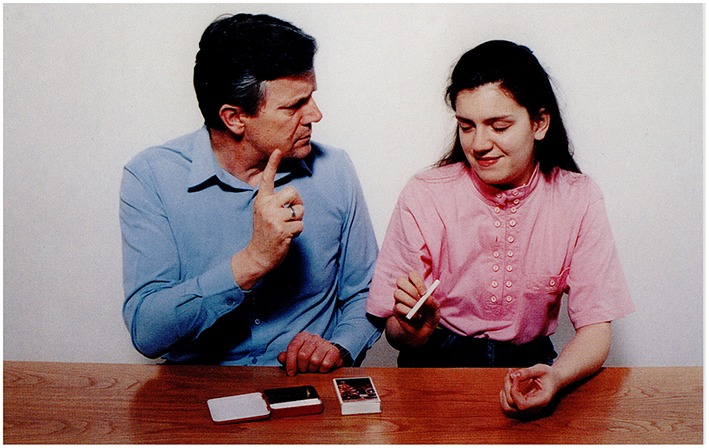
A father warns his daughter that she should not smoke (Stark, 1998).